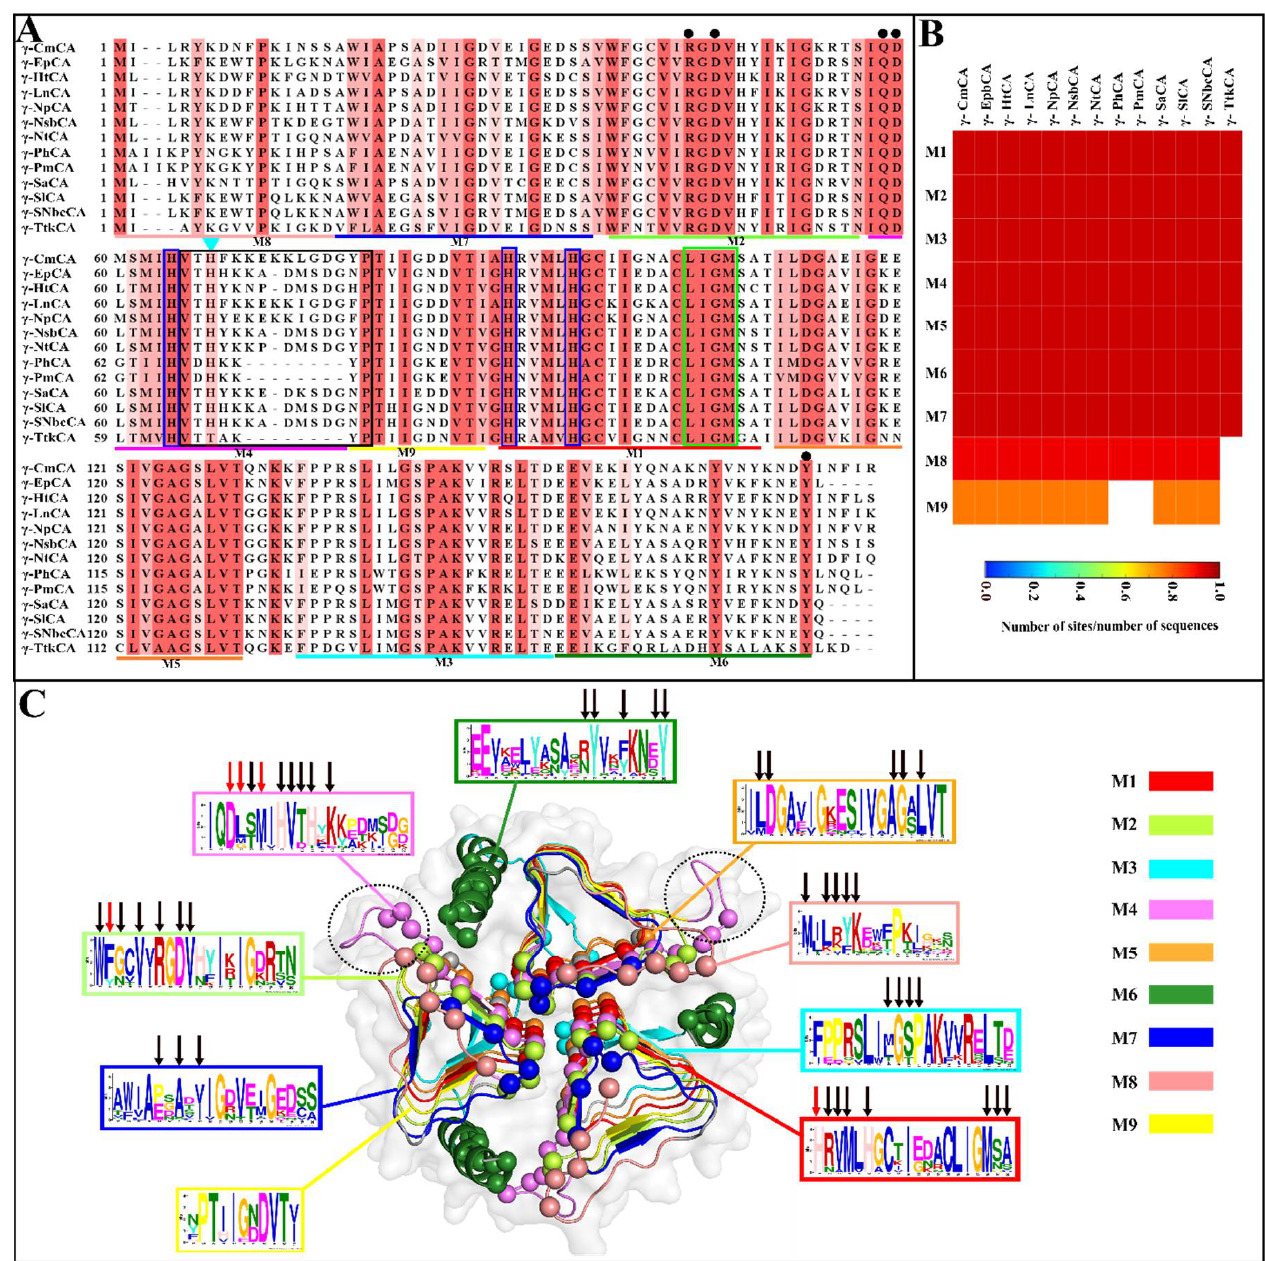
Figure 2. Multiple sequence alignment (MSA) and motif analysis of the hydrothermal γ-CA sequences. ( A ) The MSA was calculated using the T-Coffee alignment program, and residues that were more than 50% conserved are colored according to the extent of residue conservation. Residues boxed in blue are Zn 2+ -coordinating histidines, and those with a black dot above them are important for catalysis. The black box delineates the loop containing the proton-shuttling His residue, indicated by the cyan triangle, while residues in the green box are CO 2 -binding pocket residues. The lines under the alignment show the positions of the motifs, with the colors corresponding to those used in ( C ). Start and end positions for the γ-CA from Sulfurovum lithotrophicum (γ-SlCA) were used. ( B ) Heatmap showing the prevalence of motifs across the sequences. ( C ) Structure of the γ-SlCA colored according to motif positions. The spheres show residues identified in the interface. Hotspot residues are shown as red arrows on the motif logos generated by MEME, and black arrows show the interface residues. The black dotted circle shows the elongated loop in the Campylobacteria γ-CAs.